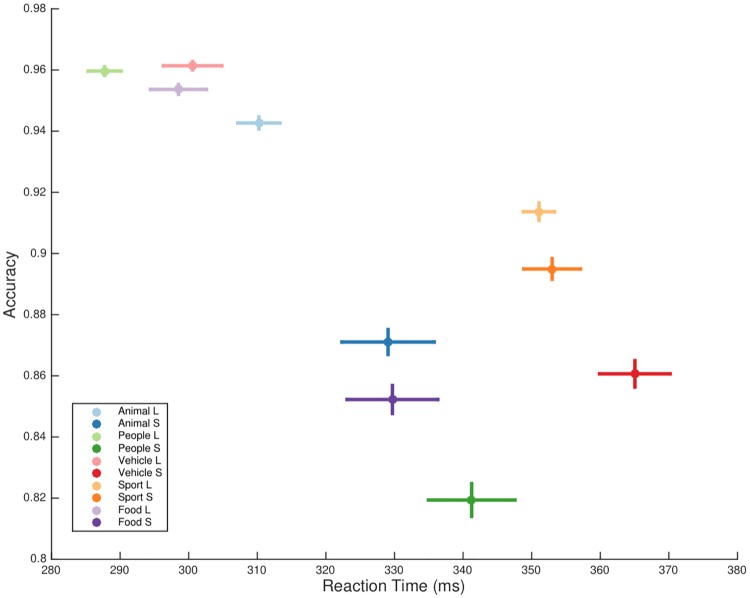
Accuracy vs. median RT for target objects at two levels of scales.To facilitate the comparison among the performance of different category targets, two extreme scales were used in this analysis: “L”—the largest level, “S”—the smallest level. Horizontal and vertical bars indicated standard error for median RTs and accuracy respectively. The values were computed using a bootstrap method that divided the samples into 10 parts.